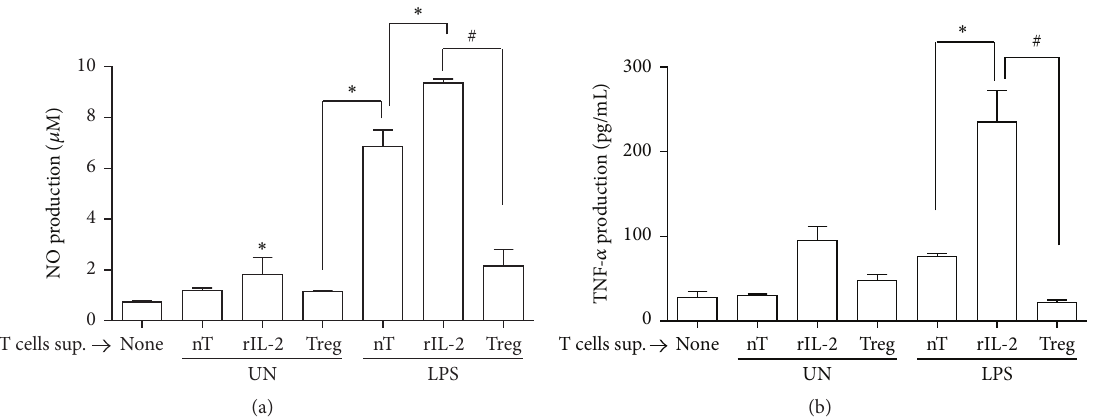
Figure 7: Treg cells confer tolerogenic potential to microglia. CD4 + T cells were treated with recombinant IL-2 in presence or absence of IL-10 for 72 hrs and the supernatants were used for pretreatment of microglia followed by stimulation with LPS; production of nitric oxide (a) and TNF- 𝛼 (b) into the culture medium was analysed by Griess reagent and ELISA, respectively. The error bars represent the mean ± SEM from three independent experiments ( ∗ 𝑝 ≤ 0.0001 versus control and # 𝑝 ≤ 0.0007 versus LPS). T cells sup.: supernatant from T cells; UT: untreated; rIL-2: recombinant IL-2; rIL-10: recombinant